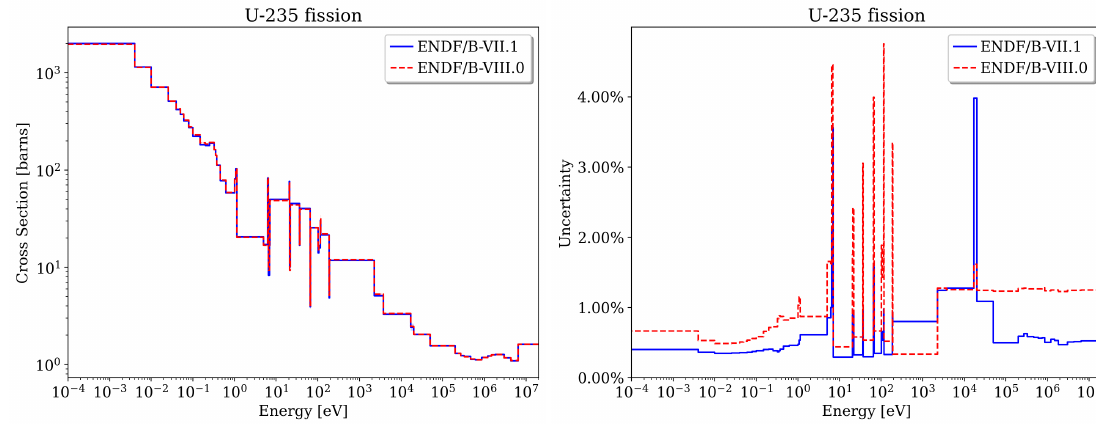
Figure A5. 235 U fission nominal data and